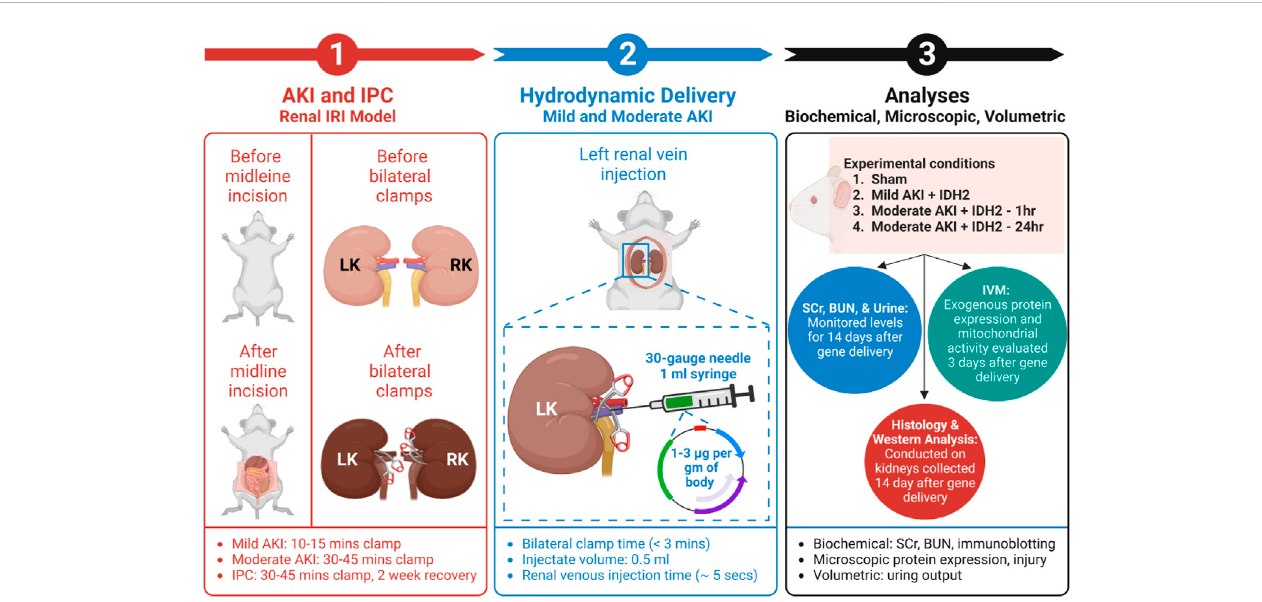
FIGURE 1 Anoutlineoftheexperimentalwork fl ow.(1)ThisexperimentalapproachbeganbysubjectinganimalstodifferentdegreesofIRItoinduceAKI via bilateral renal pedicle clamps for periods to induce mild (occluded blood fl ow for 10 – 15 min) and moderate (occluded blood fl ow for 30 – 45 min) injuries, and IPC (occluded blood fl ow for 30 – 45 min). (Corridon et al., 2013) (2) The next step included hydrodynamic gene delivery for four experimental conditions by conducting rapid retrograde injections using vascular cross-clamping into the renal vein. The experimental conditions were sham injury, mild injury followed by hydrodynamic gene delivery 1 h after reperfusion (Mild AKI + IDH2 — 1h), moderate injury followed by hydrodynamic gene delivery 1 h after reperfusion (Moderate AKI + IDH2 — 1h), and moderate injury followed by hydrodynamic gene delivery 24 h after reperfusion (Moderate AKI + IDH2 — 24 h). The injections took approximately 5 s to deliver 1 – 3 µg per Gram of plasmid DNA per body weight suspended in 0.5 mL saline (Engel et al., 2019). (3) The last phase experimentrelied on aseries ofbiochemical, microscopic, and volumetricanalyses to examine whether hydrodynamic gene delivery could upregulate IDH2 expression in the mammalian kidney and what effects altering the mitochondrial proteome in this manner could have on serum creatinine (SCr), blood urea nitrogen (BUN), and urine output levels, as well as the renal mitochondrial membrane potential ( Δψ m ) and renal microarchitecture. LK, left kidney; RK, right kidney; IVM, intravital microscopy; and IDH2, isocitrate dehydrogenase [NADP],